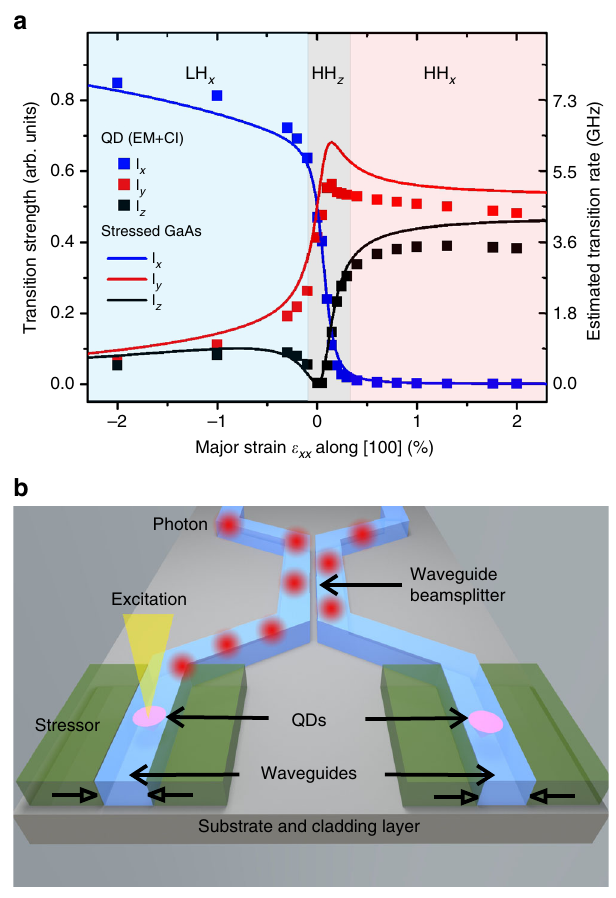
Fig. 5 Envisioned applications of strain-engineered single-photon source for integrated quantum-photonic circuits. a Calculated transition strength and estimated rates for light polarization along the x (blue), y (red), and z (black) directions for varying uniaxial stress along x for QDs with structure taken from experiment (symbols) and GaAs subject to a fi xed biaxial compression with σ xx = σ yy = − 120 MPa (solid lines). b